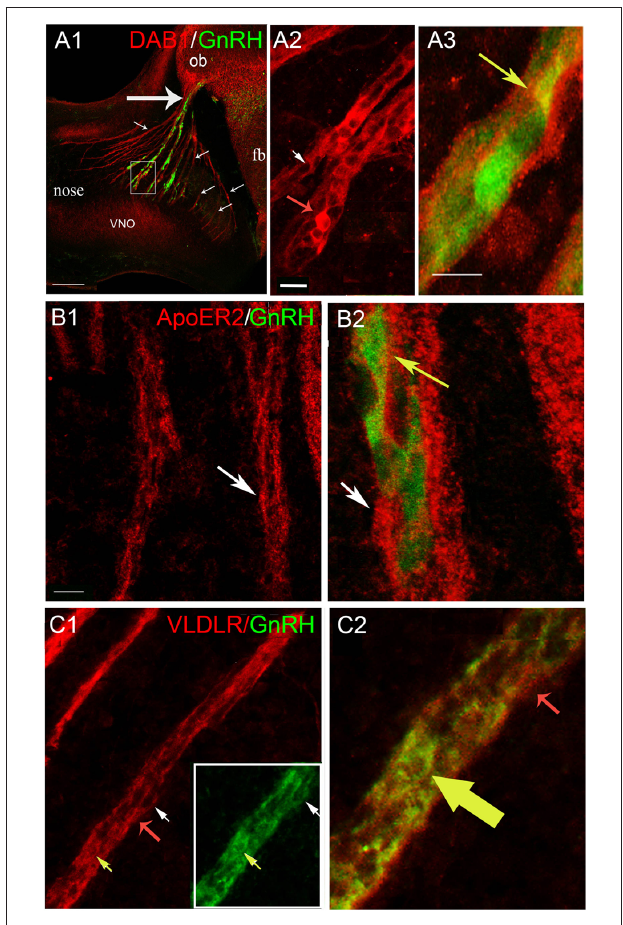
FIGURE 3 | GnRH neurons express Dab1, ApoER2 and VLDLR during of mouse embryonic development. (A–C) Sagittal section of E12.5 mice (16 µ m) immunostained with indicated antibodies; GnRH-GFP using green fluorescent protein (GFP) antibody. (A) Low magnification of embryonic head stained for Dab1 (red) and GnRH-GFP (green) shows tracks in nasal region (small arrows; with GnRH cells from the vomeronasal organ (VNO), and without GnRH cells from the olfactory epithelium), crossing to the nasal/forebrain junction (large arrow); ob, olfactory bulb; fb, forebrain. High magnification of area boxed in (A) . Double labeling for Dab1 (red, A2 ) showed expression in some GnRH-GFP cells (green, yellowed merge, A3 ). Dab1-immunoreactivity was often confined to the rim of the GnRH cells but co-expression in leading processes was detected ( A3 , yellow arrow). In addition, Dab1 positive non-GnRH cells were located along the axonal tracts ( A2 , red arrow). (A3) is higher magnification of area shown by white arrow in (A2) . (B) Immunofluorescence for ApoER2 (red) and GnRH-GFP (green) revealed co-expression in GnRH cells crossing the nasal mesenchyme ( B2 , higher magnification of B1 , merged, yellow arrow, white arrow is same location in both B1 , B2 ). ApoER2 was also detected on other elements along the migratory pathway ( B , white arrows). (C) Double labeling for VLDLR (red) and GnRH-GFP (green) indicated that the majority of GnRH neurons expressed VLDLR (Boxed area in C1 , shown at higher magnification, merged in C2 , yellow and red arrows indicate same location in C1 , C2 ). As with Dab1 and ApoER2, VLDLR was also detected on other elements along the migratory pathway ( C , red arrows). Scale bar = 200 µ m in (A1) , 20 µ m in (A2) (same in B1,C1 ) and 40 µ m in (A3) (same in B2,C2 ).